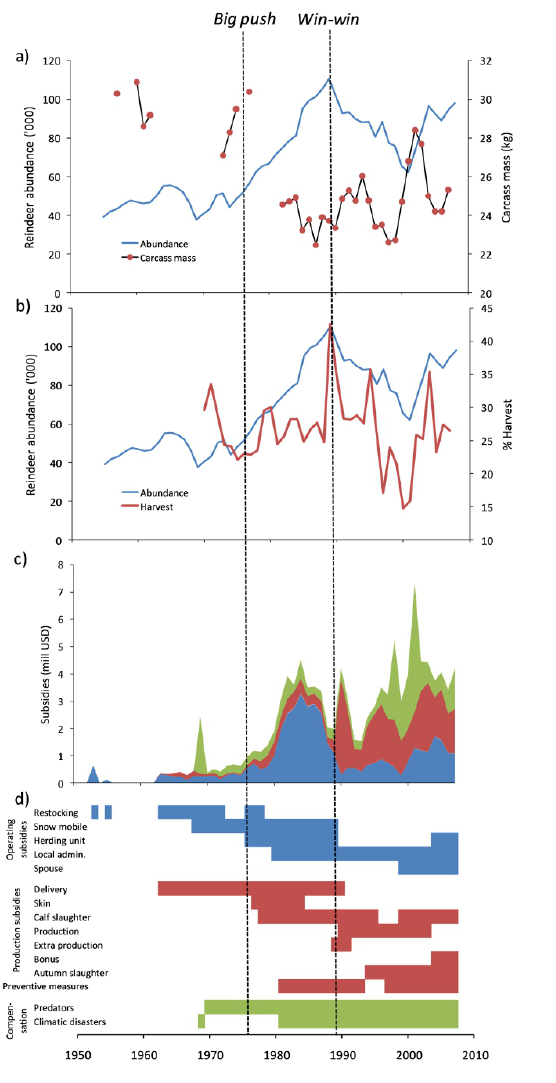
Fig. 1. Time course featuring the relationship between economic security policies, harvest rates, reindeer abundances, and carcass mass. Dashed vertical lines indicate major policy shifts. The postwar period was characterized by economic deprivation. Welfare policies started in the 1960s, but the big push was initiated with the first General Agreement for the Reindeer Industry in 1976. Sustainability measures were introduced in 1989, and the subsequent period has been characterized by ex ante and ex post policies toward environmental risks. (a) Reindeer abundance (herd size in spring before calving) and carcass mass. (b) Reindeer abundance and percent annual harvest (animals slaughtered in percent of herd size before calving). (c,d) Operating costs (blue) dominate in the big push period. Production subsidies and preventive measures (red) work mainly ex ante, whereas compensations work ex post (green). (c) Total disbursement in USD (adjusted according to the 2008 CPI). (d) Time period for disbursement of the different subsidies and compensations (see Appendix 1 for detailed descriptions of time period, requirements, and quality of the